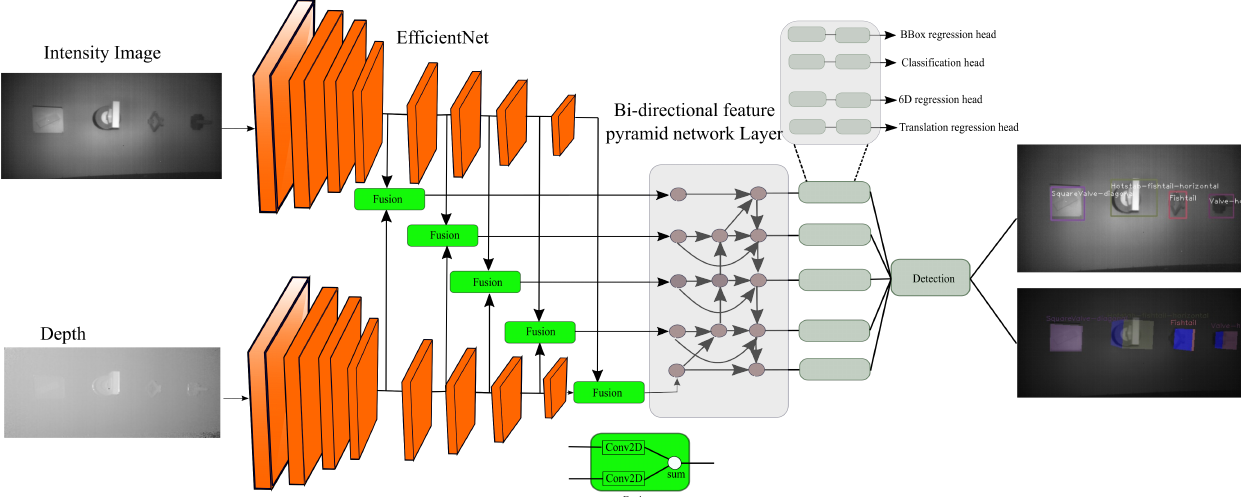
Figure 4. Overview of the proposed 6D pose estimation network. Input features are extracted from intensity and depth image with an EfficientNet [20] encoder. Features from both streams are fused at different scales and passed to bidirectional feature pyramid networks (BiFPN) and the prediction subnetworks. Both intensity and depth input images are the size of ( 512 × 512 ) . The output shape for bbox regression, classification, 6D regression and translation heads are 4 × N c , 1 × N c , 6 × N c and 3 × N c , respectively, where N c is the number of anchor boxes used for object